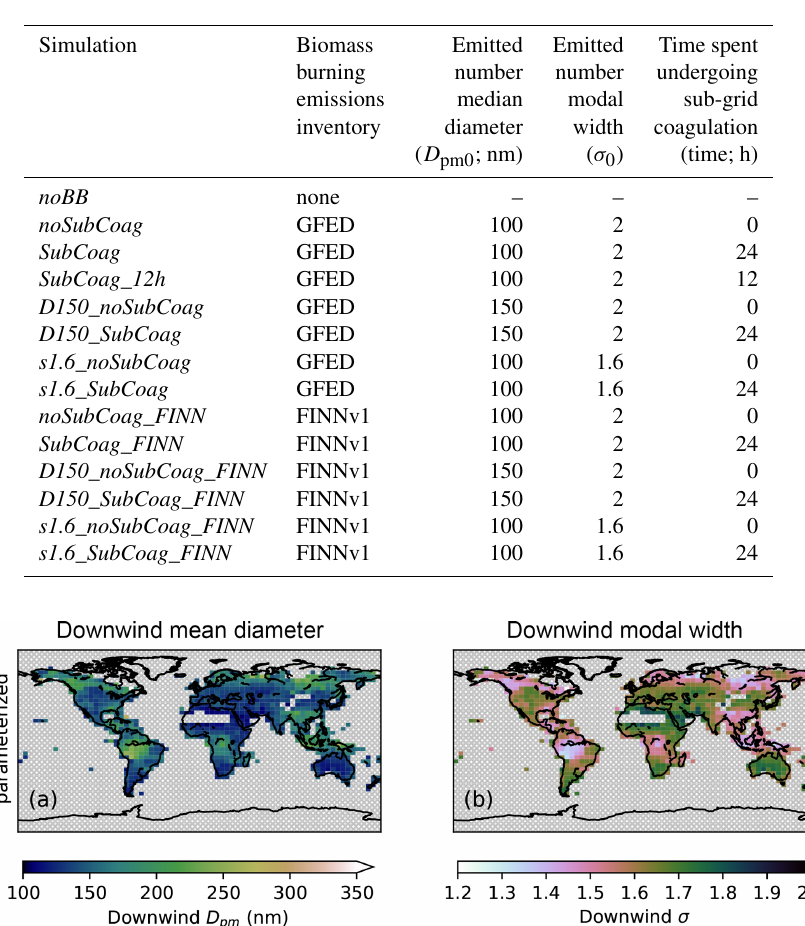
Table 1. Simulation names and descriptions of GEOS-Chem parameters which change depending on the simulation. In the naming, “Sub- Coag” refers to the inclusion of sub-grid coagulation, and “noSubCoag” indicates the exclusion of sub-grid coagulation. The default size distribution has an emitted median diameter of 100nm and an emitted modal width of 2. “D150” in the name indicates that the median diameter is increased to 150nm. “s1.6” indicates that the modal width is decreased to 1.6 (with the “s” coming from “sigma”). The default biomass burning emissions inventory is GFED, and simulations using FINNv1 instead include “FINN” in their names. The default amount of time spent undergoing sub-grid coagulation is 24h, and the simulation with only 12h spent aging has a “ _12h ” suffix.